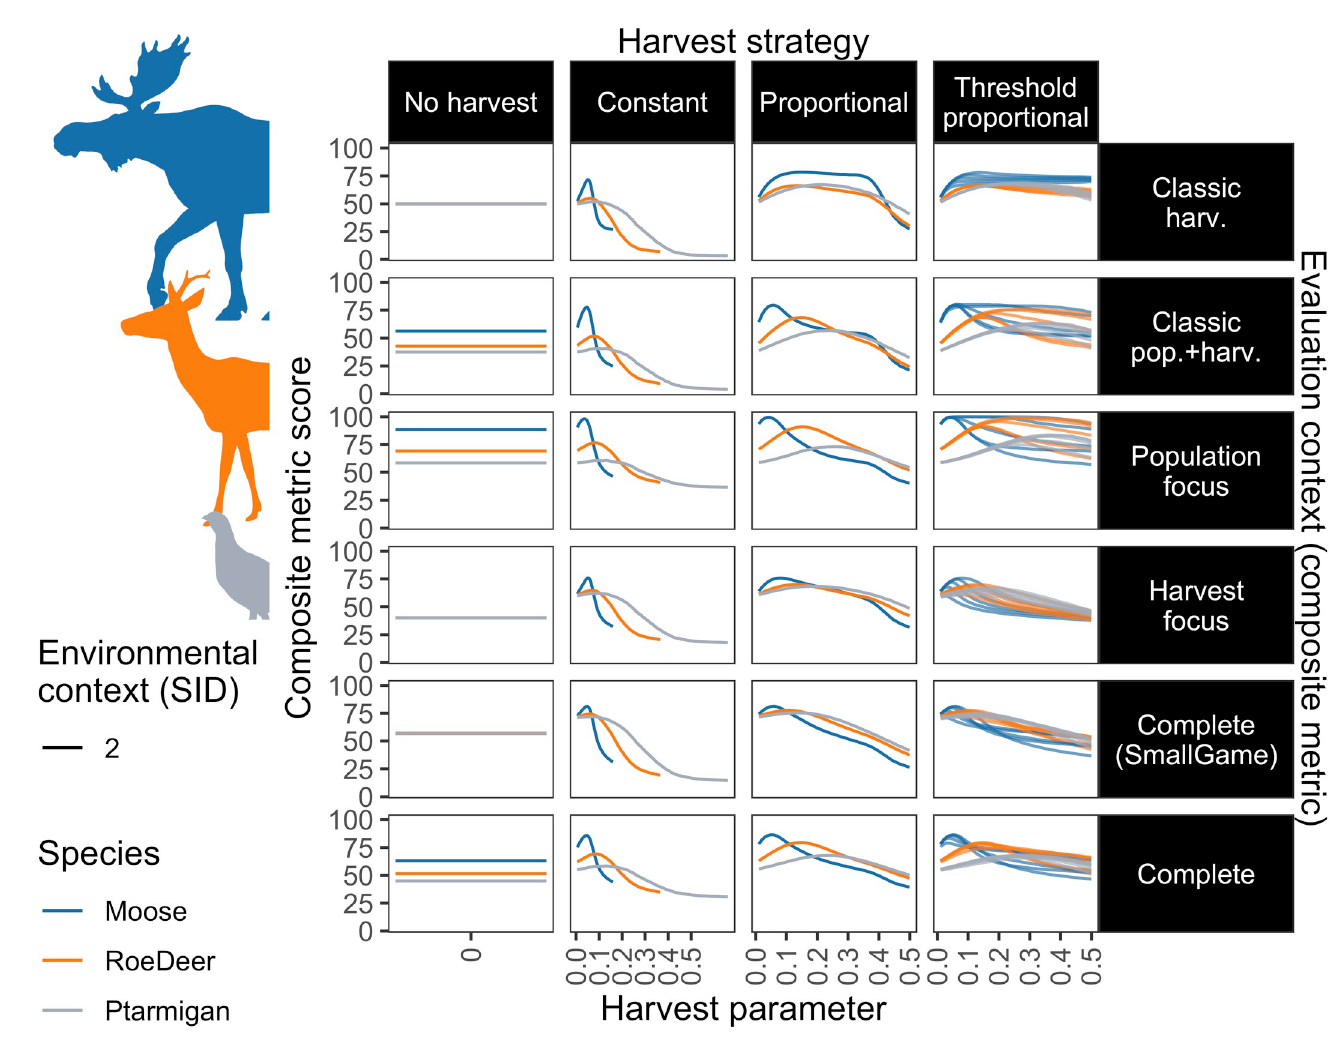
Fig 2. Composite scores across harvest strategies and parameters. Composite scores (y-axis) for each composite metric set (panel rows), under each harvest strategy (panel column) and harvest parameter (x-axis). For the constant harvest strategy (second column), the x-axis shows the constant scaled by the maximum constant per species. For the threshold proportional strategy (fourth column), the x-axis shows the proportion, and multiple lines per species show selected thresholds from across the range of thresholds tested. Species are indicated by line colour, and are here shown for the environmental context with high variability/uncertainty and moderate starting- population sizes (SID 2). Results for other scenarios and including variability are in S2.1 Section in S2 Appendix.